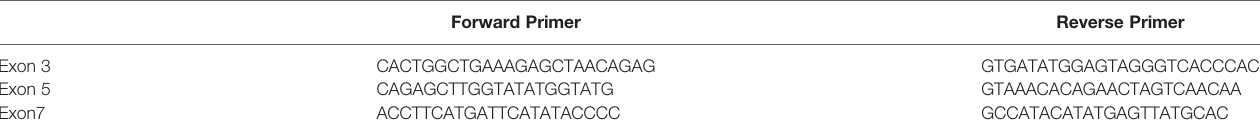
TABLE 1 | Forward and reverse primers used for sequencing of Exon 3 ( CYP2C9*2 & CYP2C9*8 ), Exon 5 ( CYP2C9*6 ), and Exon 7 ( CYP2C9*3 , CYP2C9*5 & CYP2C9*11 ).